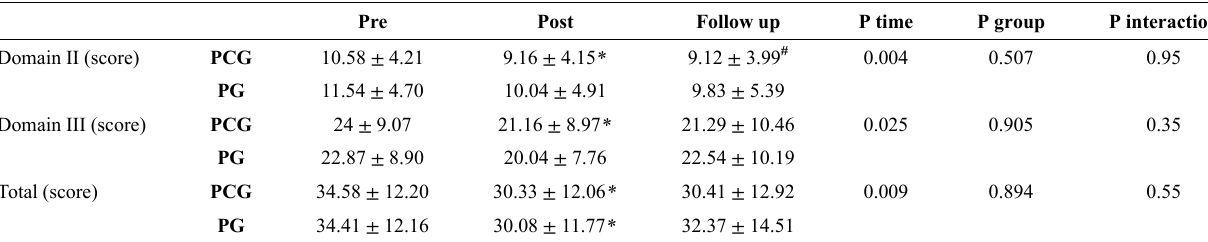
Table 4 - Data on